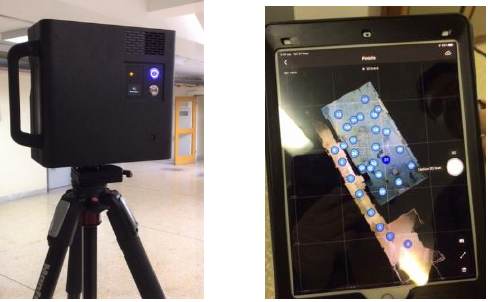
Figure 3. Matterport Pro2 3D and the display of data in the app during the acquisition